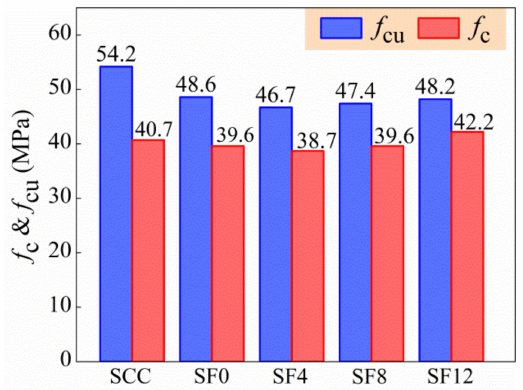
Figure 9. Compressive strength of tested